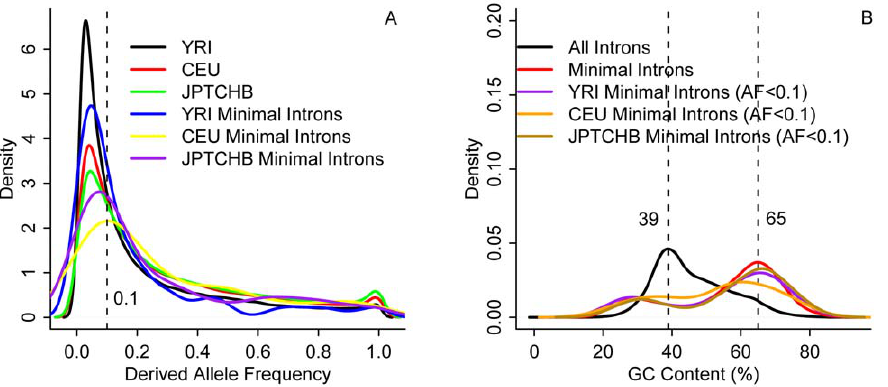
Figure 1. Estimation of key parameters. The distributions of derived allele frequency or DAF (A) and GC content (B) of minimal introns among the three studied populations: Africans (YRI), Europeans (CEU), and Asians (JPTCHB). The dashed lines divide the thresholds for DAF (A) and intron GC content (B).